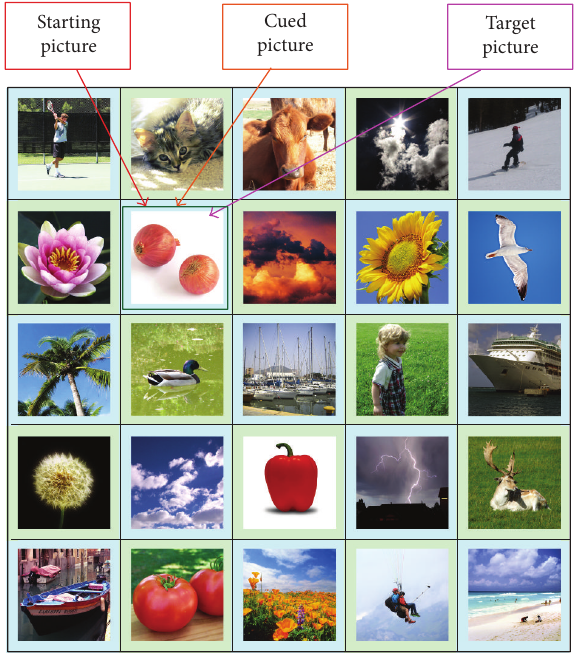
Figure 11: An example of a challenge